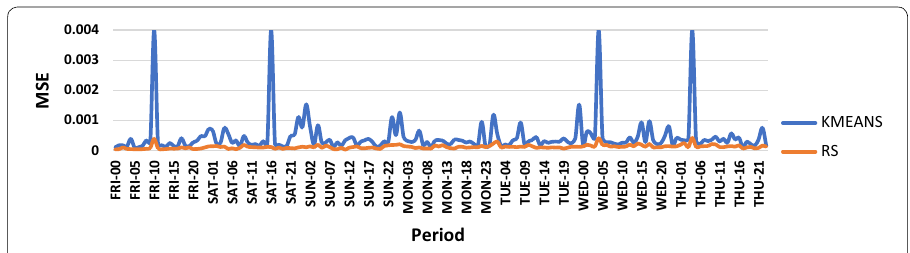
Fig. 7 MSE value for trips origin